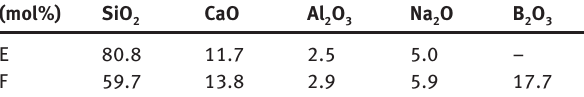
Table 2: Selected glass compositions in SiO 2 -CaO-Al 2 O 3 -Na 2 O and SiO -CaO-Al O -Na O-B O systems to produce porous glass using 2 2 3 2 2 3 spinodal decomposition.